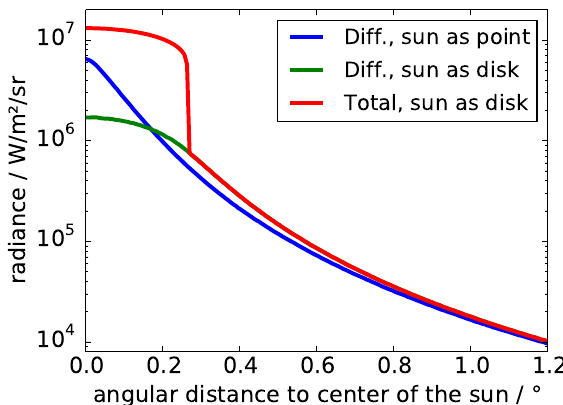
Fig. 1. Simulated broadband sunshape (integrated solar) for a cir- rus cloud with optical thickness 0.5 and with the Sun in the zenith. Blue: diffuse radiance for a point source. Green: diffuse radiance for a disk source. Red: direct and diffuse radiance for a disk source. Optical properties for a cirrus composed of HEY solid columns (see Sect. 2.3) with an effective radius of 40µm were employed in the